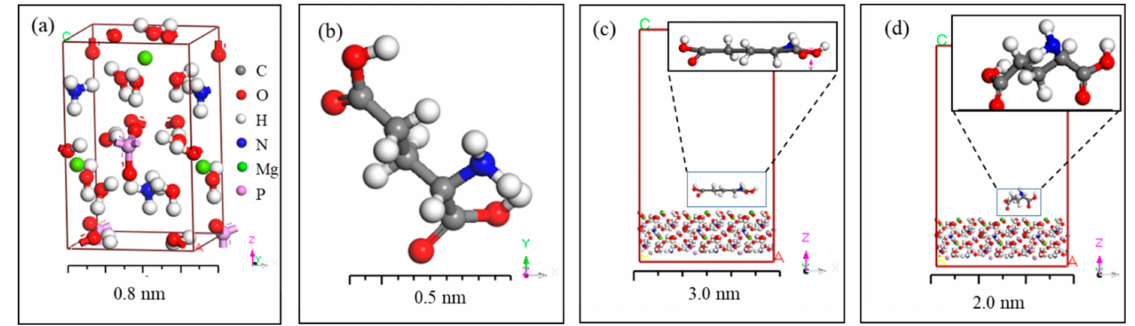
Figure 3. Molecular dynamics simulation of adsorption of Glu onto a struvite crystal: ( a ) 3D structure of a struvite crystal; ( b ) the molecular structure of Glu; ( c , d ) the configuration before and after adsorption of Glu onto (111) faces of struvite, respectively. Table 2. The interaction energy between Glu and various surfaces of struvite crystals (kcal / mol).